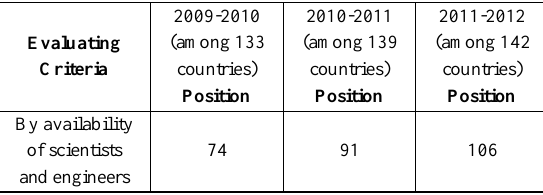
Table 1: Kazakhstan's position on the factor